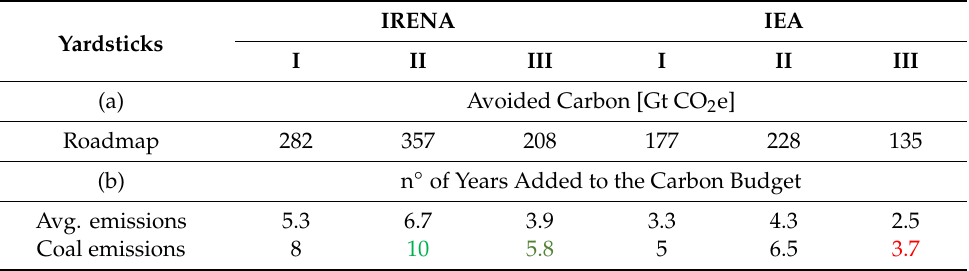
Table 4. Avoided carbon and increased carbon